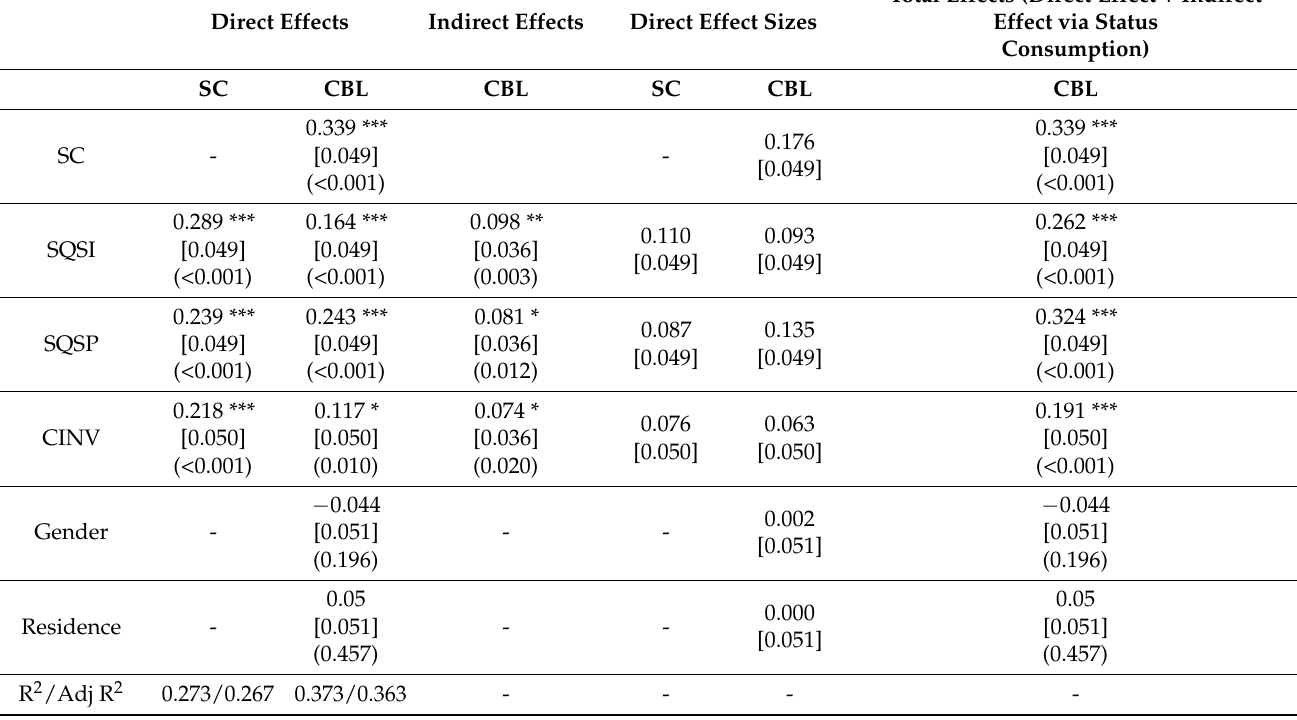
Table 9. The first structural equation